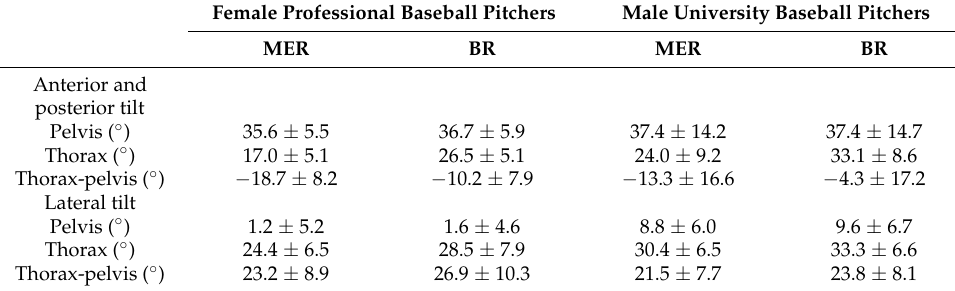
Table 4. Tilt of the pelvis and thorax.